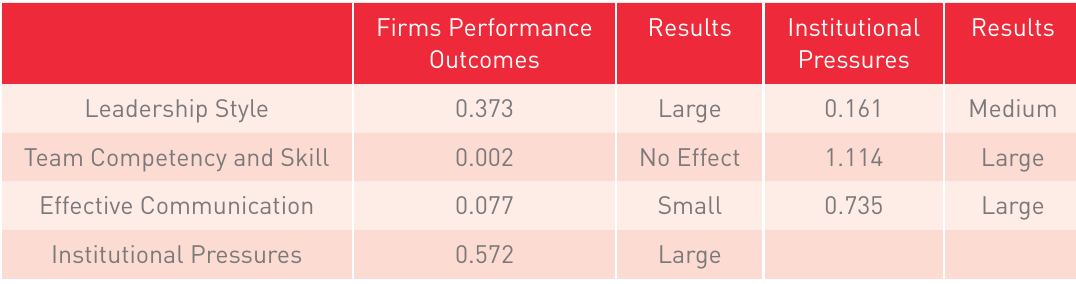
F-Square of the Endogenous Latent Variables